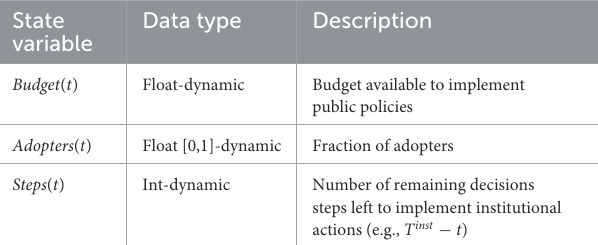
Algorithm 1 details the pseudocode of the model. During the